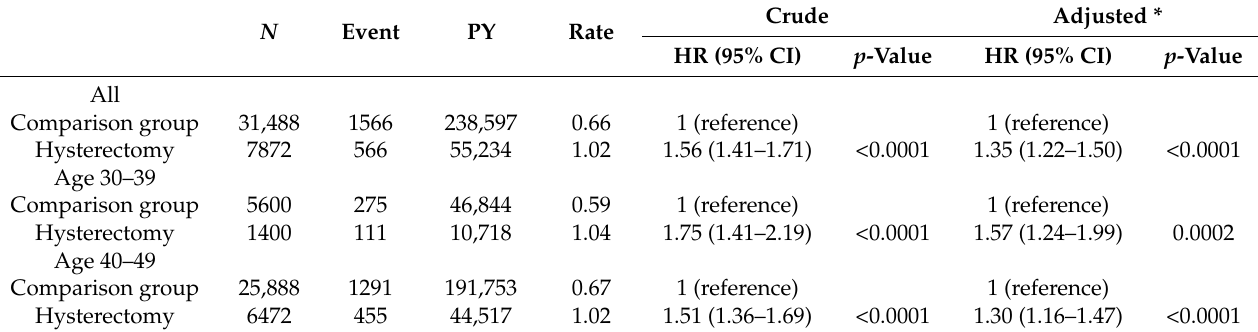
Table 2. Risk of depression in women with hysterectomy compared to comparison group.